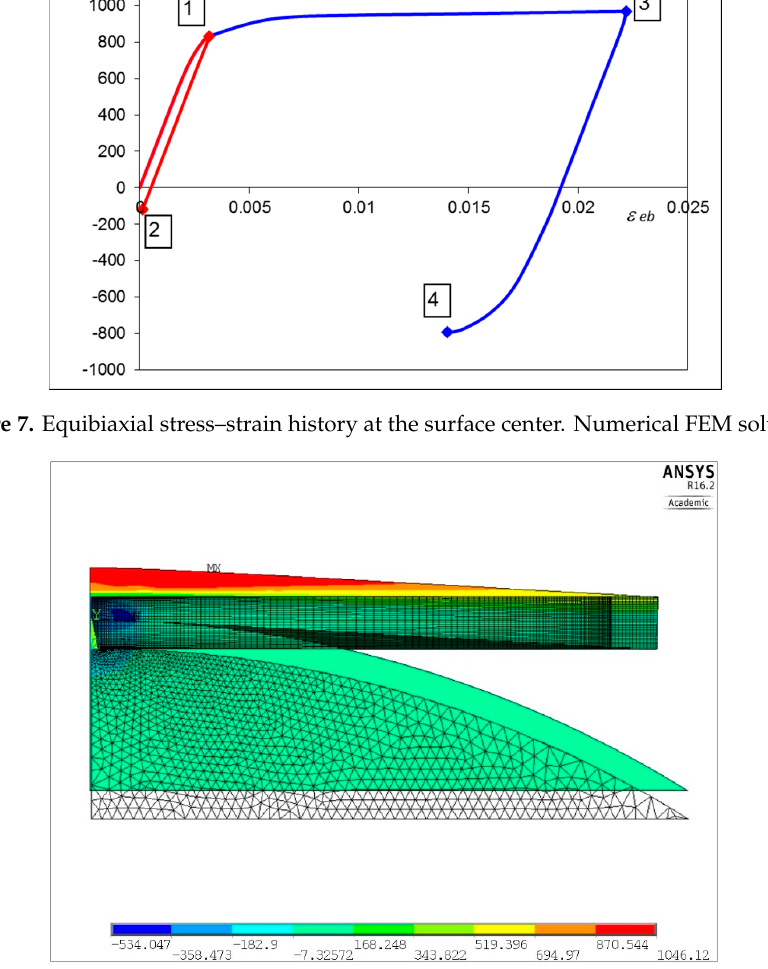
Figure 7. Equibiaxial stress–strain history at the surface center. Numerical FEM solution.